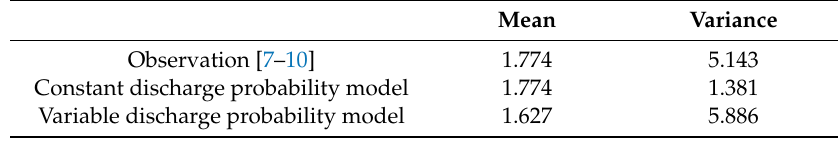
Figure 1. Log-likelihood versus discharge probability.